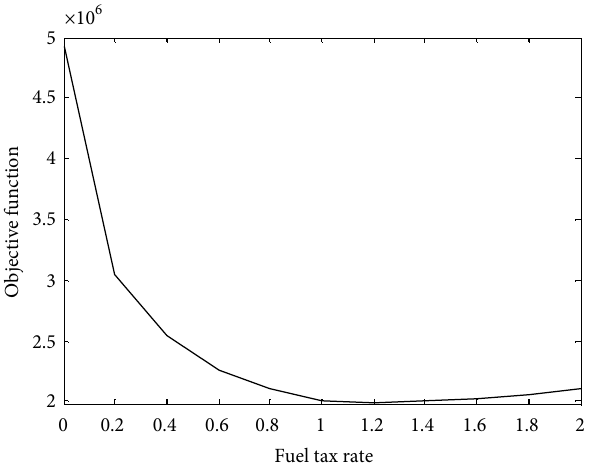
Figure 2: The process of objective function changing with fuel tax rate. Table 4: Optimization results of direct bus lines when Direct bus line no.